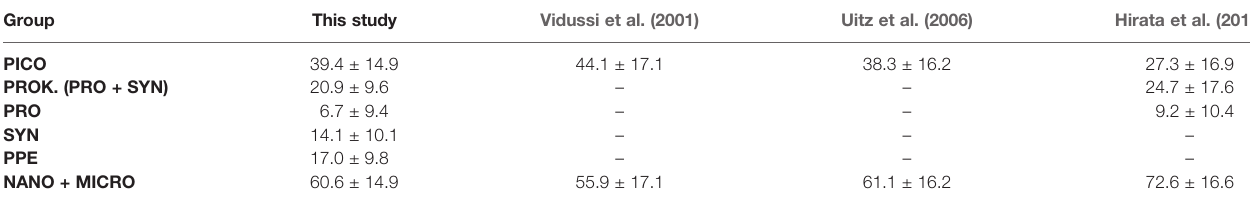
TABLE 3 | Comparison between group-speci fi c Chl a fractions (% total Chl a) based on measured per-cell Chl a (this study) versus estimates derived from HPLC concentrations using the algorithms of Vidussi et al. (2001), Uitz et al. (2006), and Hirata et al. (2011). Group